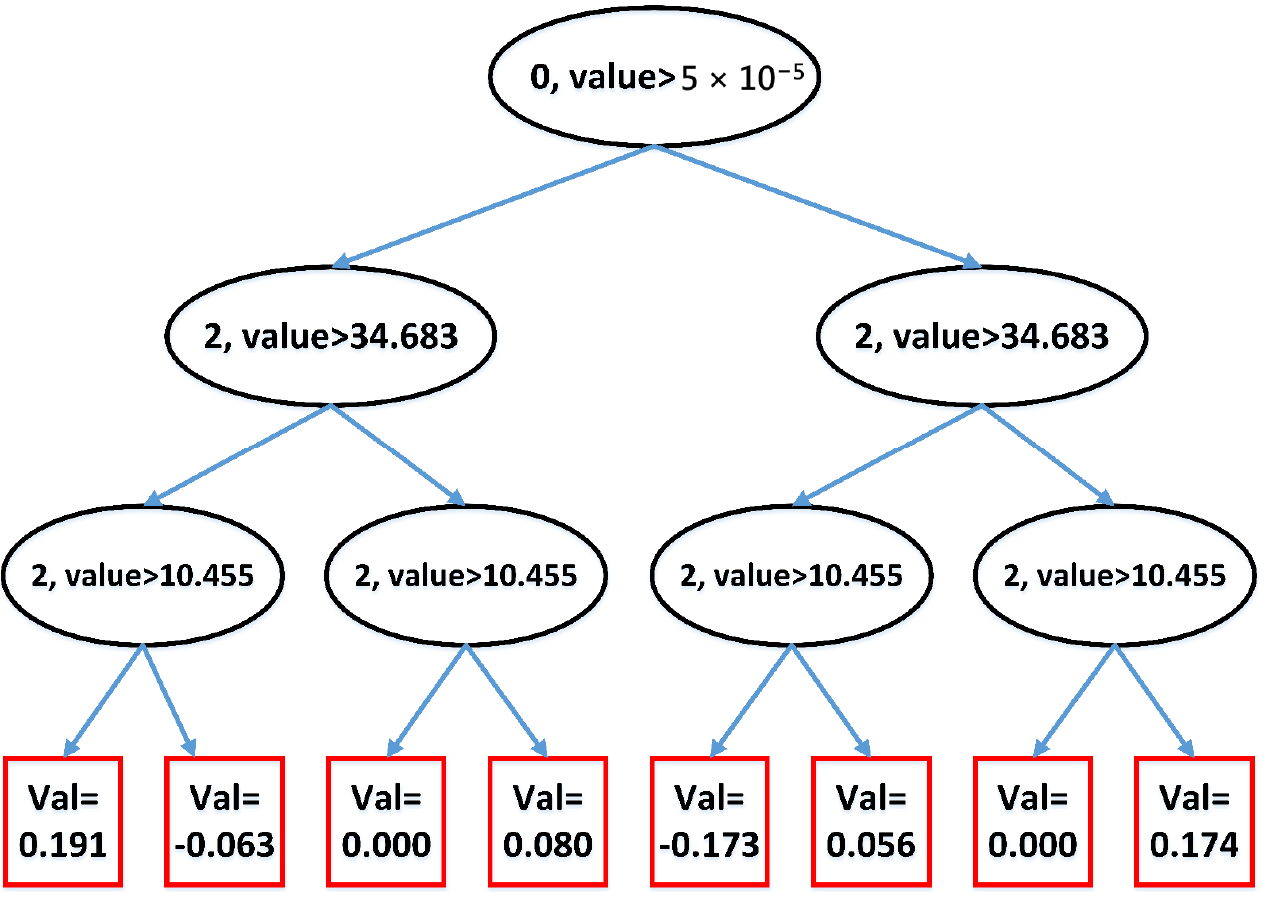
Figure 9. CatBoost Mechanism